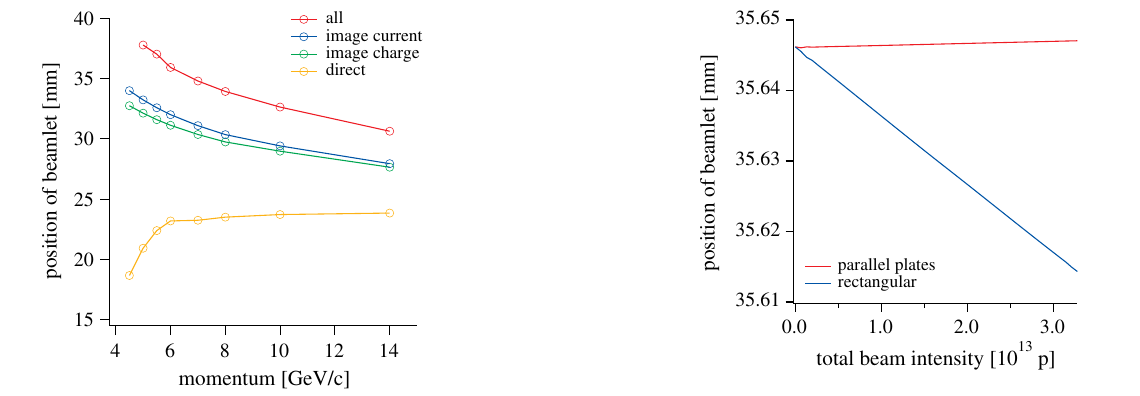
FIG. 11. Beamlet ’ s position as a function of the beam mo- mentum (the total beam intensity is 3 . 28 × 10 13 p) for h 2 ¼ 6 . 255 and parallel plates electric boundary conditions. and Q x